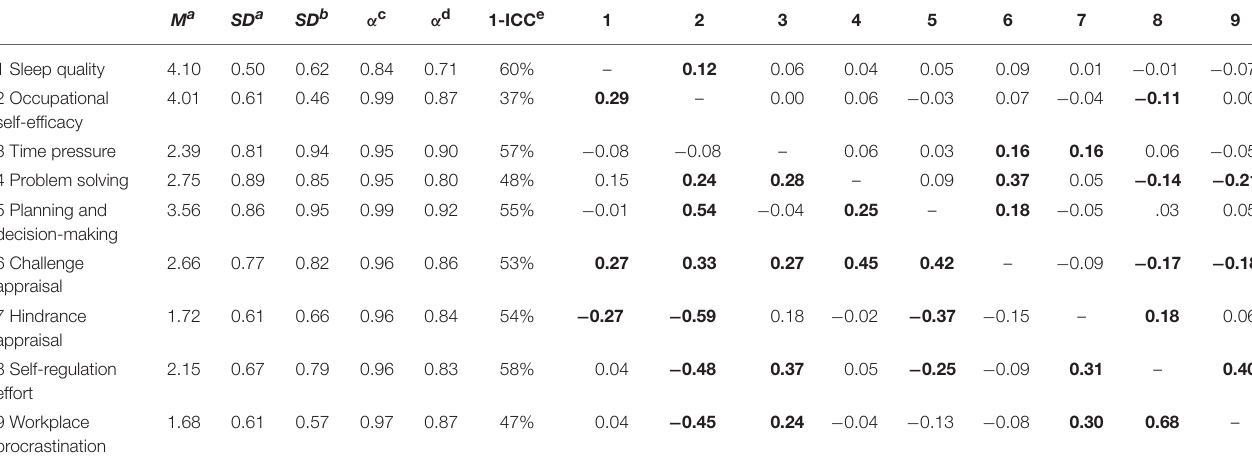
TABLE 1 | Means, standard deviations, Cronbach’s alphas, day-level variance, and zero-order correlations of study